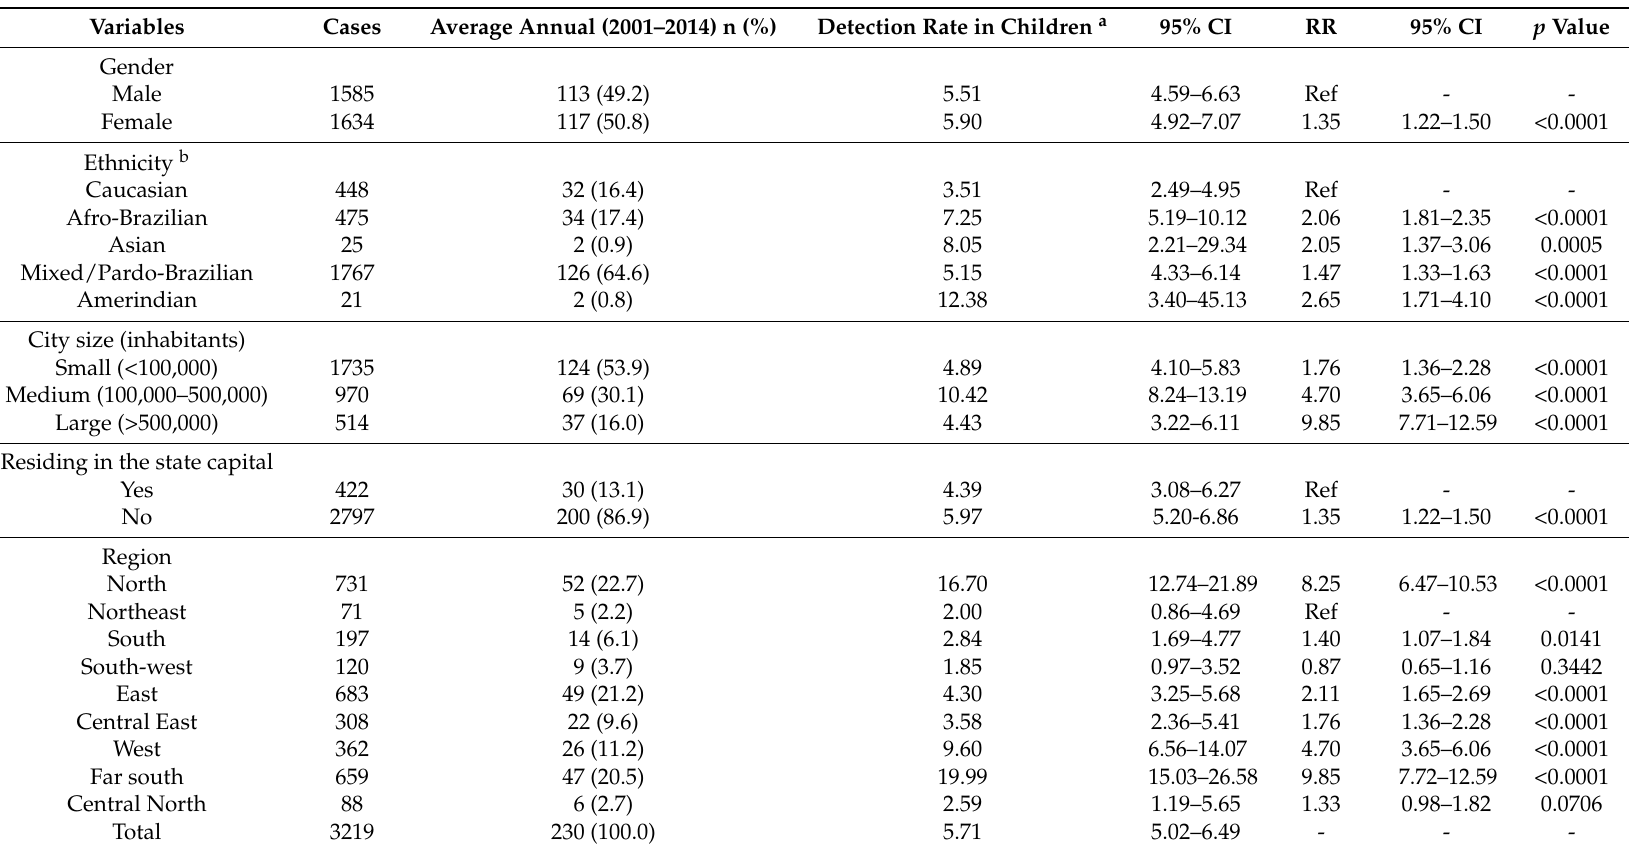
Table 2. Sociodemographic characteristics of leprosy cases in <15 year-olds and associated factors in Bahia state,